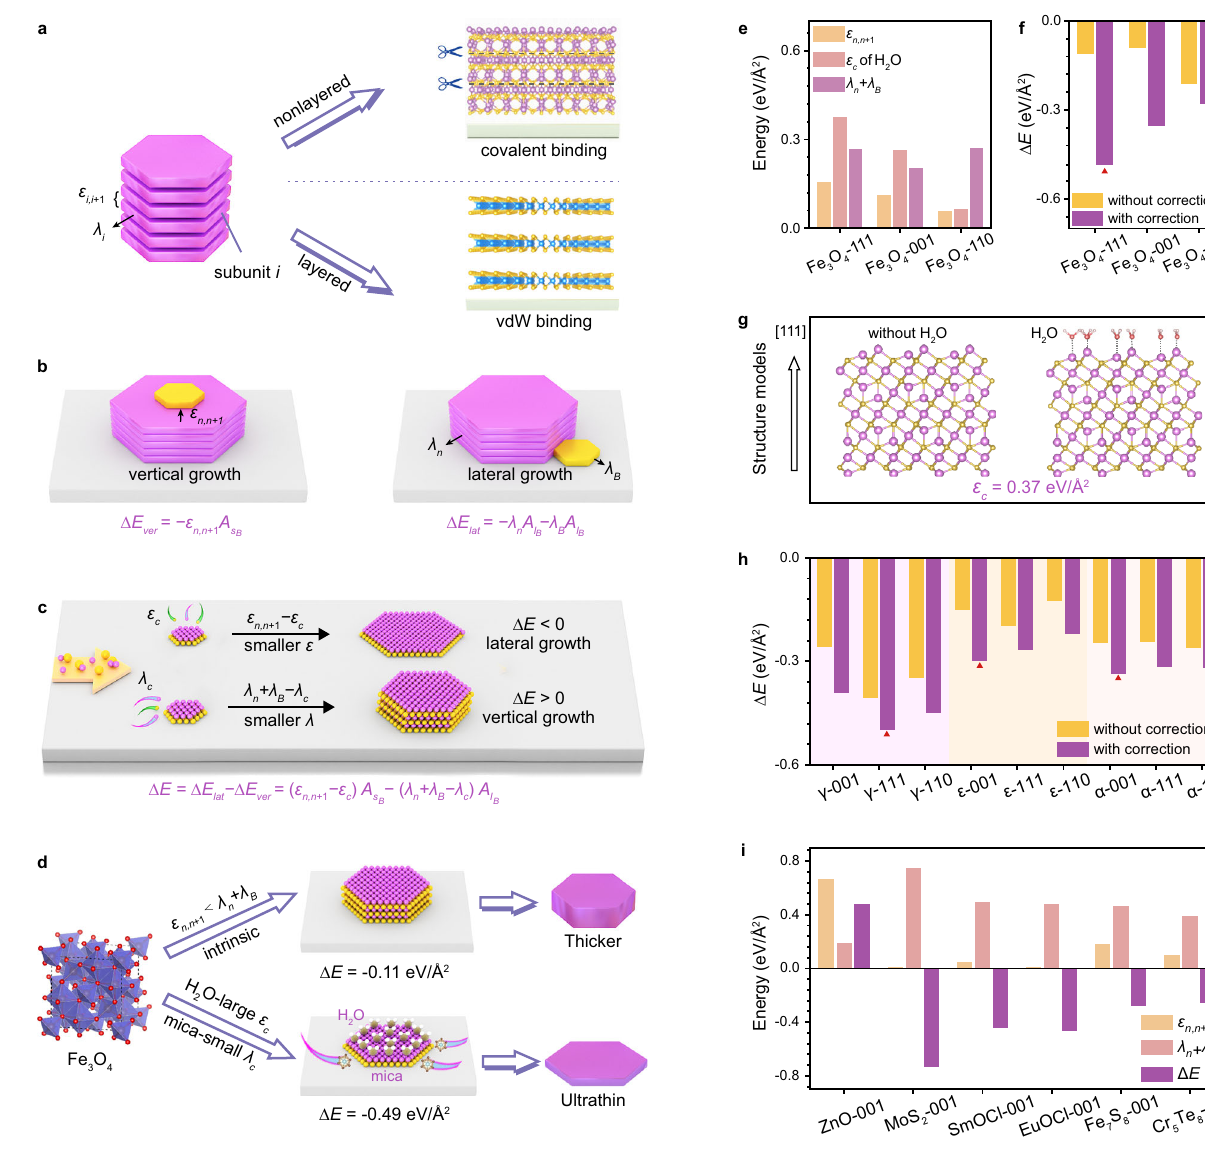
vertical growth. ε c is the circumstance correction term of the interaction energy and λ c is the circumstance correction term of the edge energy. d A schematic for the growth process of 2D Fe 3 O 4 nano fl akes along the [111] direction guided by the TTCG model. The intrinsic binding energy difference is not negative enough. The facilitation of H 2 O passivation (large ε c ) and mica substrate (small λ c ) lead to smaller Δ E , and therefore promote the synthesis of ultrathin Fe 3 O 4 nano fl akes. e Every calculated value in the model for Fe 3 O 4 with different orientations. f Total Δ E with and without circumstance correction terms for Fe 3 O 4 with different orientations. g OptimizedstructuresofFe 3 O 4 alongthe[111]directionwithoutand with the H 2 O adsorption. h Total Δ E of γ -, ε -, α -Fe 2 O 3 in different orientations with and A l and without correction terms. Red triangles indicate the lowest energy. B B i Calculated values in the growth model of ZnO, MoS 2 , SmOCl, EuOCl, Fe 7 S 8 , and Cr 5 Te 8